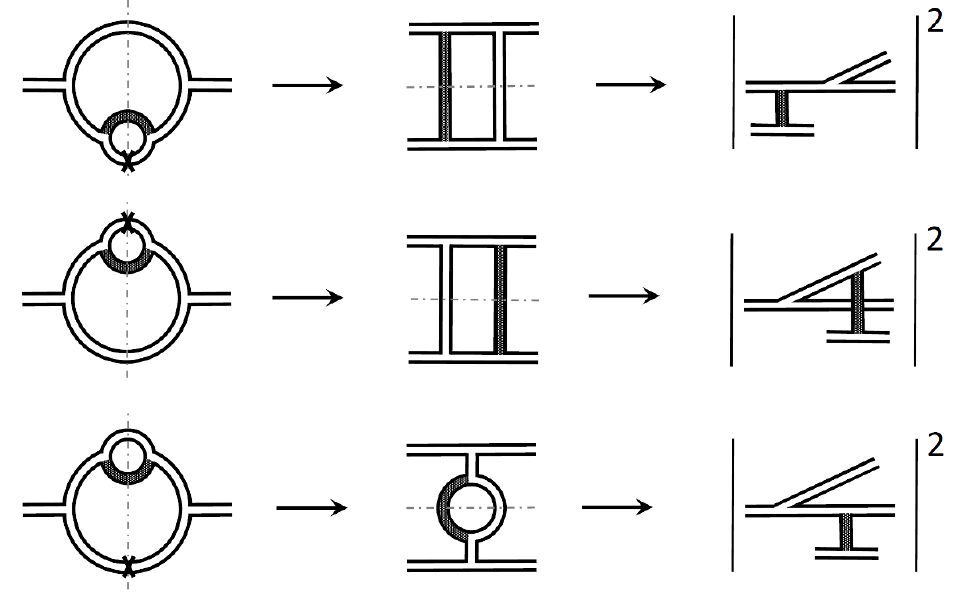
Figure 9 . The procedure showing how the number changing processes with a soft gluon exchange are reproduced from the two-loop self-energy. The dashed line is the cutting line, the black cross denotes the line opened to reproduce rungs, and the shaded line denotes a propagator with a soft momentum, which contains the hard thermal loop